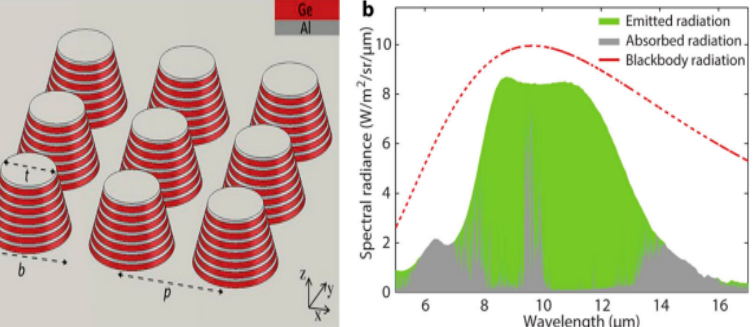
Figure 18. ( a ) Thermal emitter design utilizing multilayer conical metamaterial pillar (CMM) arrays ( b ) Calculated spectral radiance of the CMM structure at 300 K ambient temperature and the percentage of atmospheric radiance that is absorbed within the structure are shown in the shaded green area (shaded gray) [100].